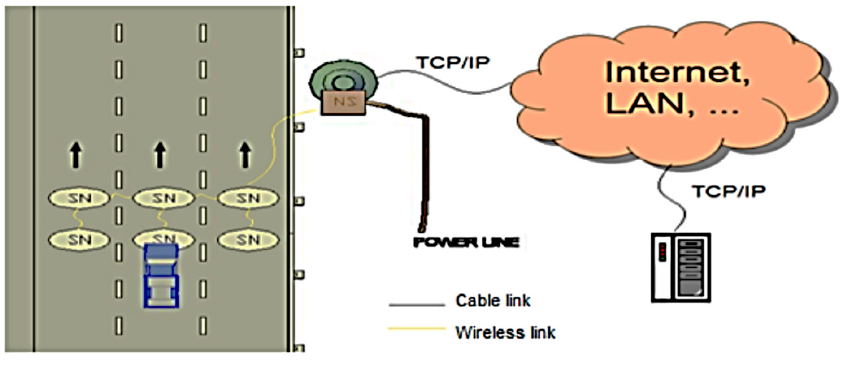
Figure 17. A depiction of the various setups where WSNs can be deployed [48].